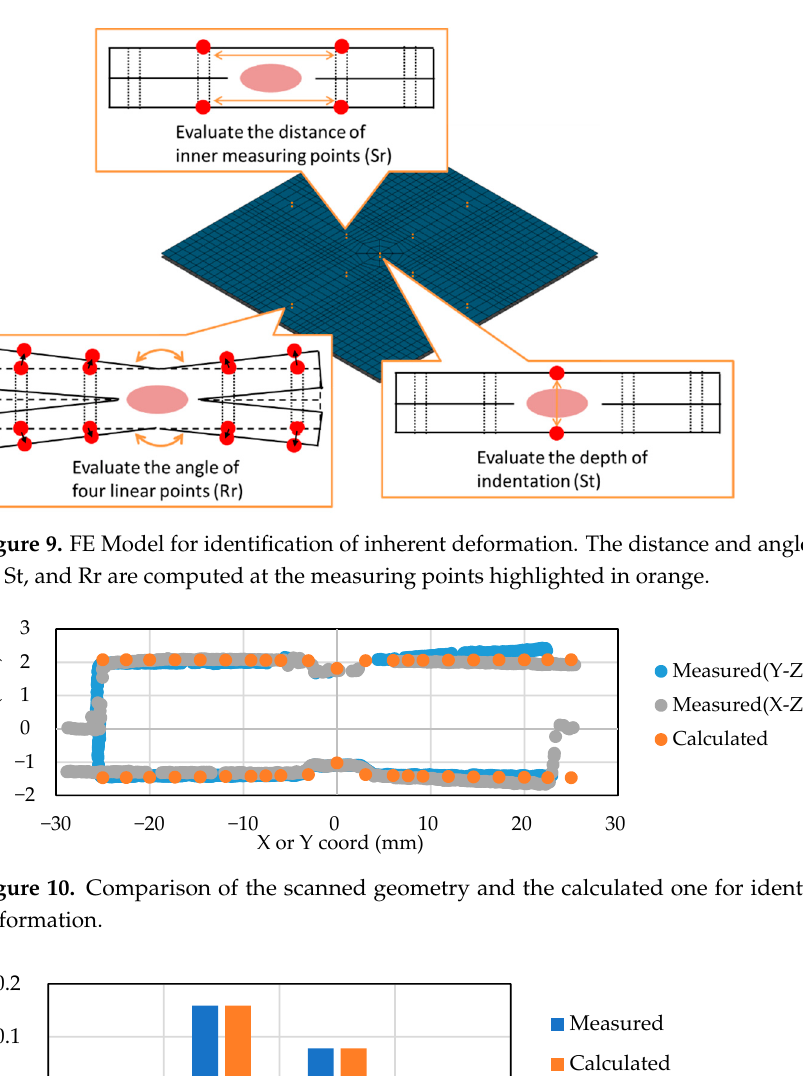
Figure 9. FE Model for identification of inherent deformation. The distance and angle for evaluating Sr, St, and Rr are computed at the measuring points highlighted in orange.